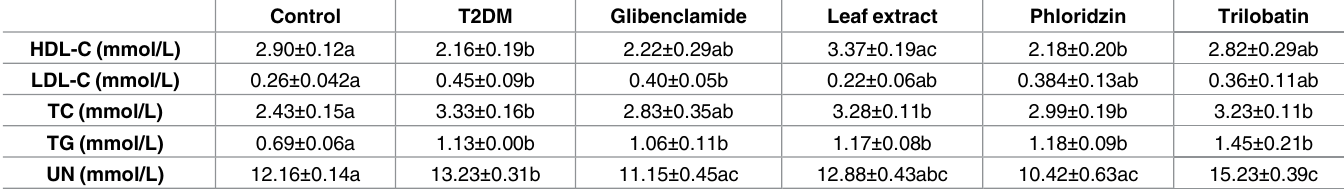
After 4 weeks’ treatment, lipid levels were performed. The data were analyzed with ANOVA. The values are expressed as the mean ± SEM, n = 10. Columns labeled with different letters are significantly different at P <